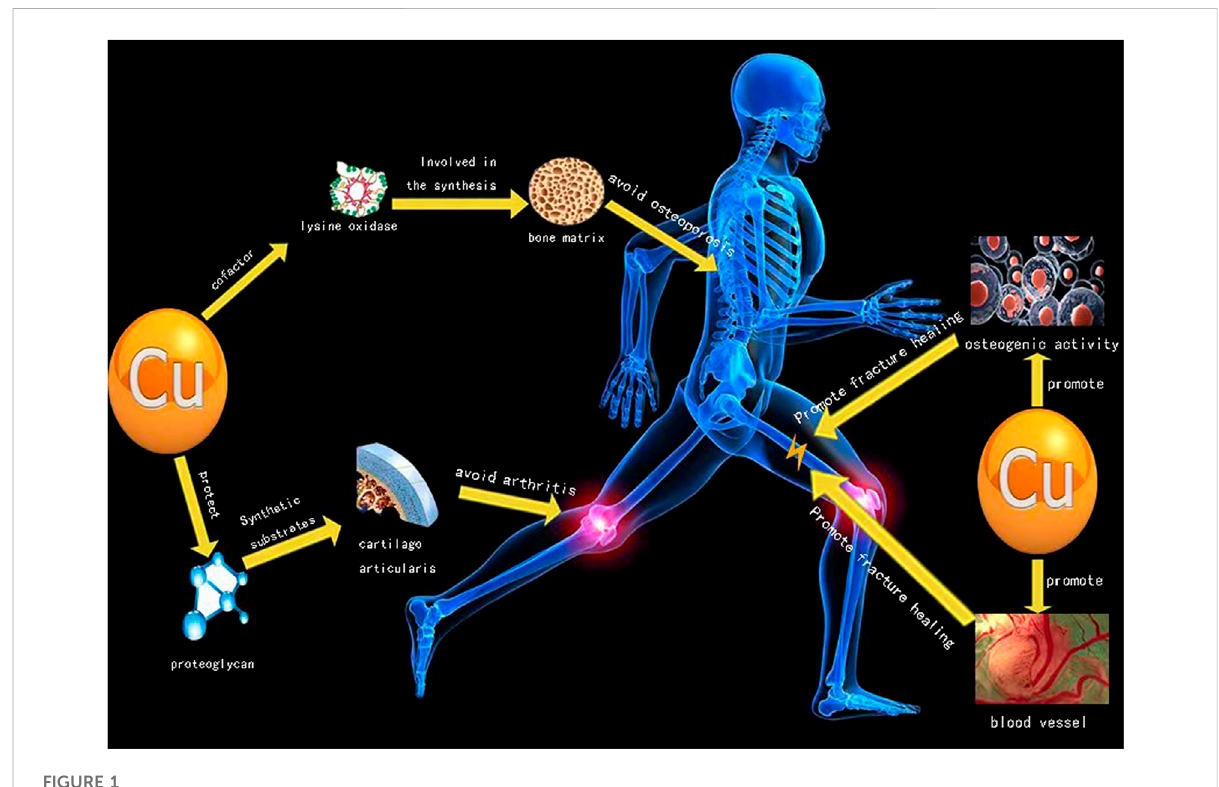
FIGURE 1 Implications of copper for treating diseases in